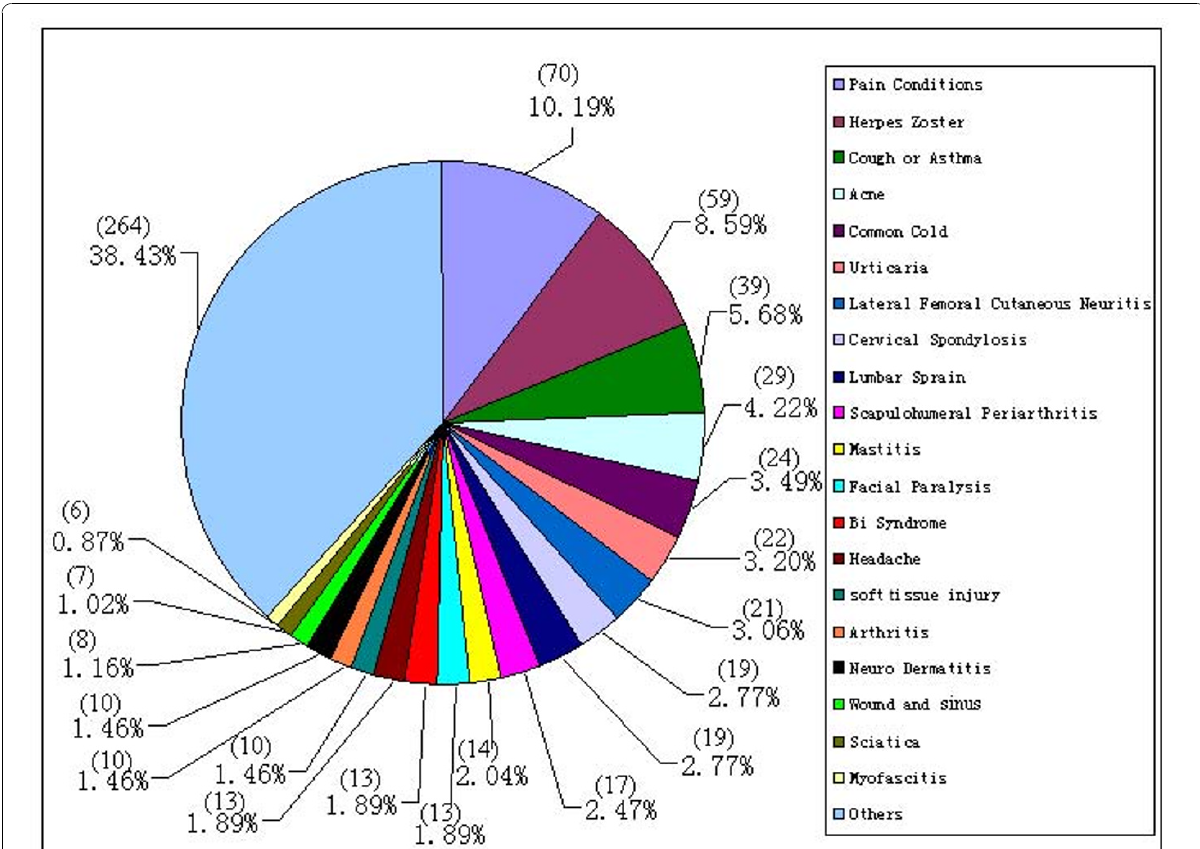
Figure 4 Constituent ratio of the diseases which were reported in literatures that were treated by cupping